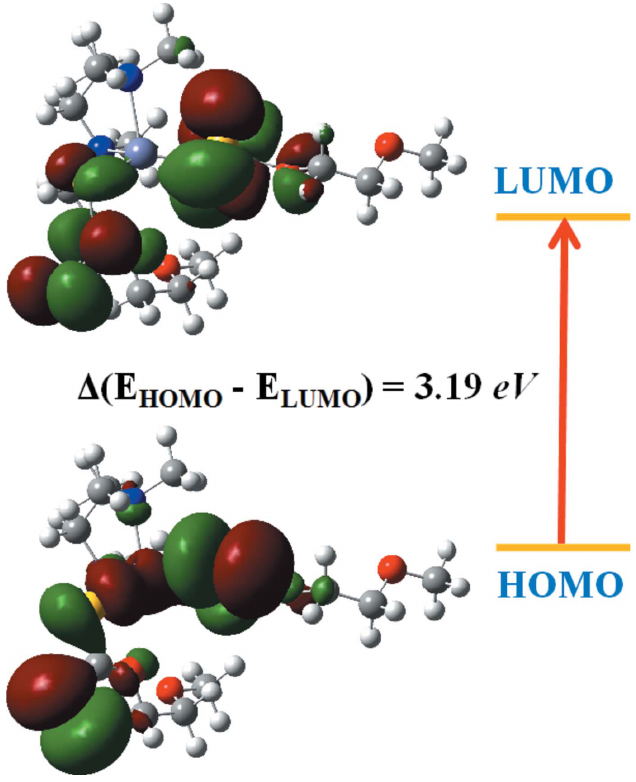
Figure 3 The electron distribution of the HOMO and LUMO energy levels of the title compound.